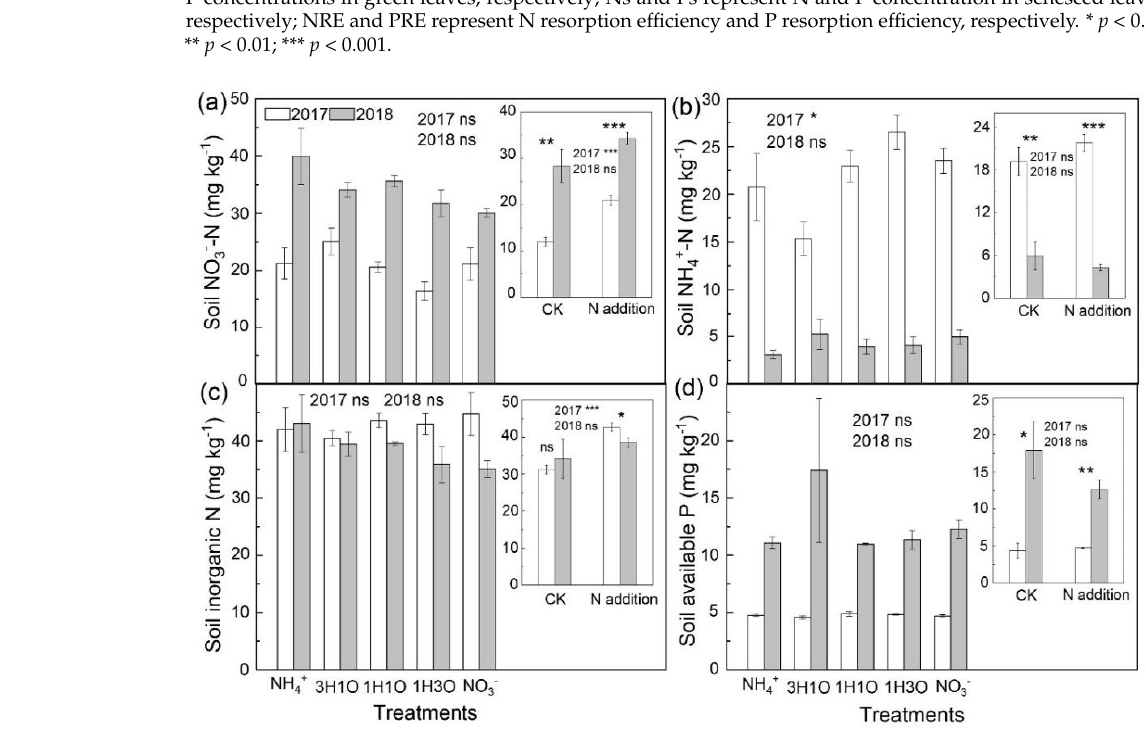
Figure 2. Response of soil NO 3- -N (a), NH 4+ -N (b), inorganic N (c) and available P (d) to various N form fertilizations. The asterisks and ns above the white and gray bar graphs represent the significance between 2017 and 2018. The asterisks and ns following the number of years inside the little figure represent the significance in control ( n = 4) and N addition (average, n = 20). The asterisks and ns following the number of years outside the figure represent the significance in N addition groups. * p < 0.05; ** p < 0.01; *** p < 0.001; ns, not significant.